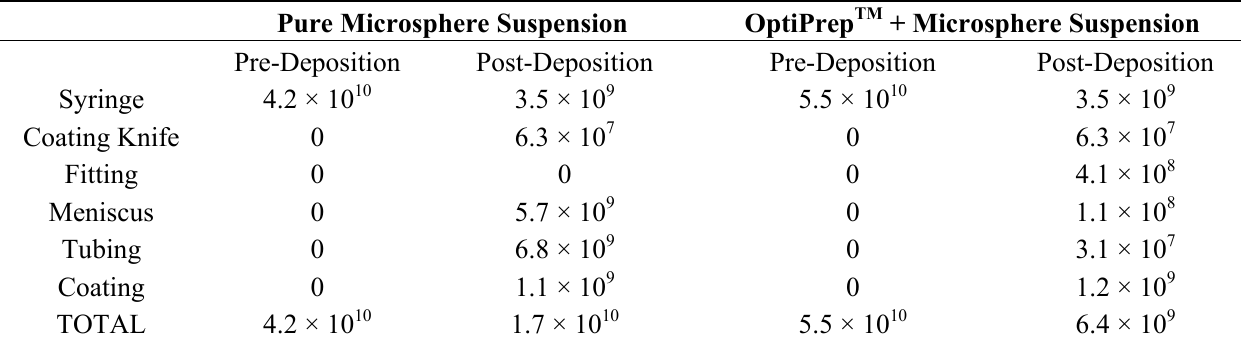
Table 1. Microsphere counts before and after deposition of a pure microsphere suspension of 8% solids and an OptiPrep TM -enriched suspension containing ~2%